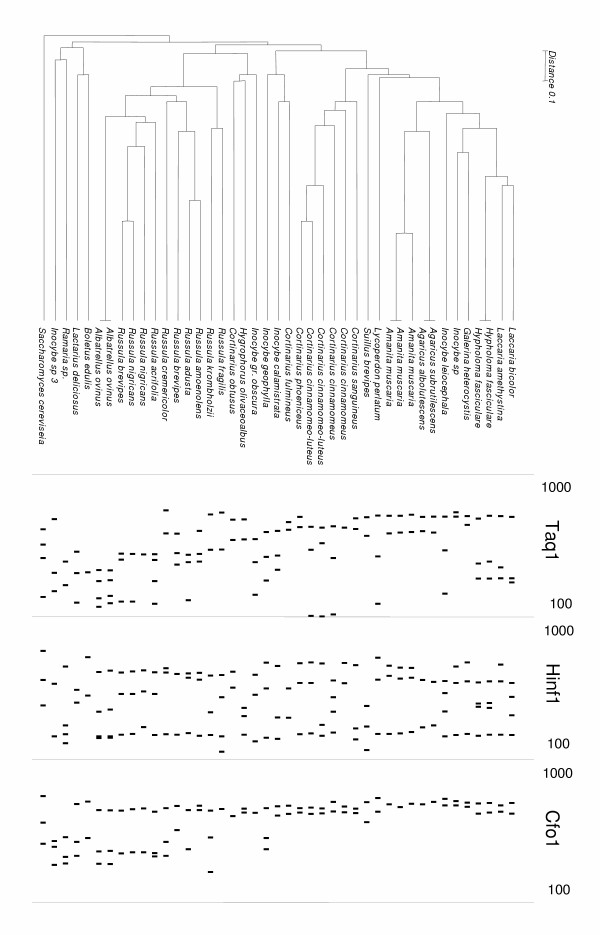
Dendrogram and PCR-RFLP patterns for sporocarps. The upper section shows the species names and the cluster tree resulting from presences/absence analysis of the PCR-RFLP data. PCR-RFLP fragment sizes are presented below in base pairs for Taq1, HinF1 and Cfo1 restrictions as indicated at the right of the figure.